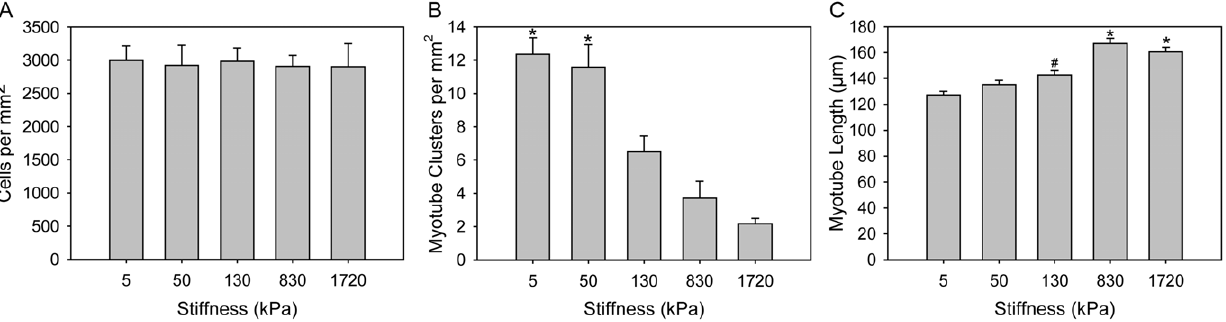
Figure 9. Quantification of cell density, myotube length and myotube clustering performed as a function of the PDMS elastic modulus. (A) Average cell density of the different PDMS formulations shows no difference as a function of substrate elastic modulus. (B) Average number of myotube clusters per mm 2 on the different PDMS formulations (n=9). The cells cultured on the 5 and 50 kPa substrates formed significantly more myotube clusters compared to the other substrates (*indicates p , 0.001). (C) Average length of myosin heavy chain positive myotubes on the different PDMS formulations (5 kPa, n=706; 50 kPa, n=739; 130 kPa, n=662; 830 kPa, n=769; 1.72 MPa, n=760). Cells cultured on the stiffer 1.72 MPa and 830 kPa substrates formed significantly longer myotubes compared to those formed on the softer 130, 50 and 5 kPa substrates (*indicates p , 0.001). Cells cultured on the 130 kPa substrate also formed longer myotubes compared to those formed on the 5 kPa substrate ( # indicates p , 0.001). Data represented as mean 6 standard error of the mean, statistical analysis by Kruskal Wallis ANOVA on the ranks with p , 0.05 Dunn’s method for pairwise comparison.